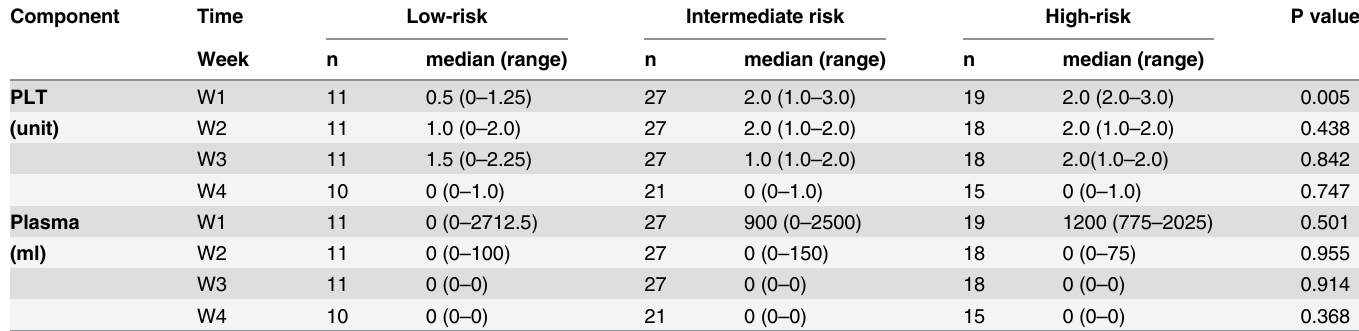
Table 6. Change in the trend of consumption of component blood in patients with APL with different prognostic stratification.